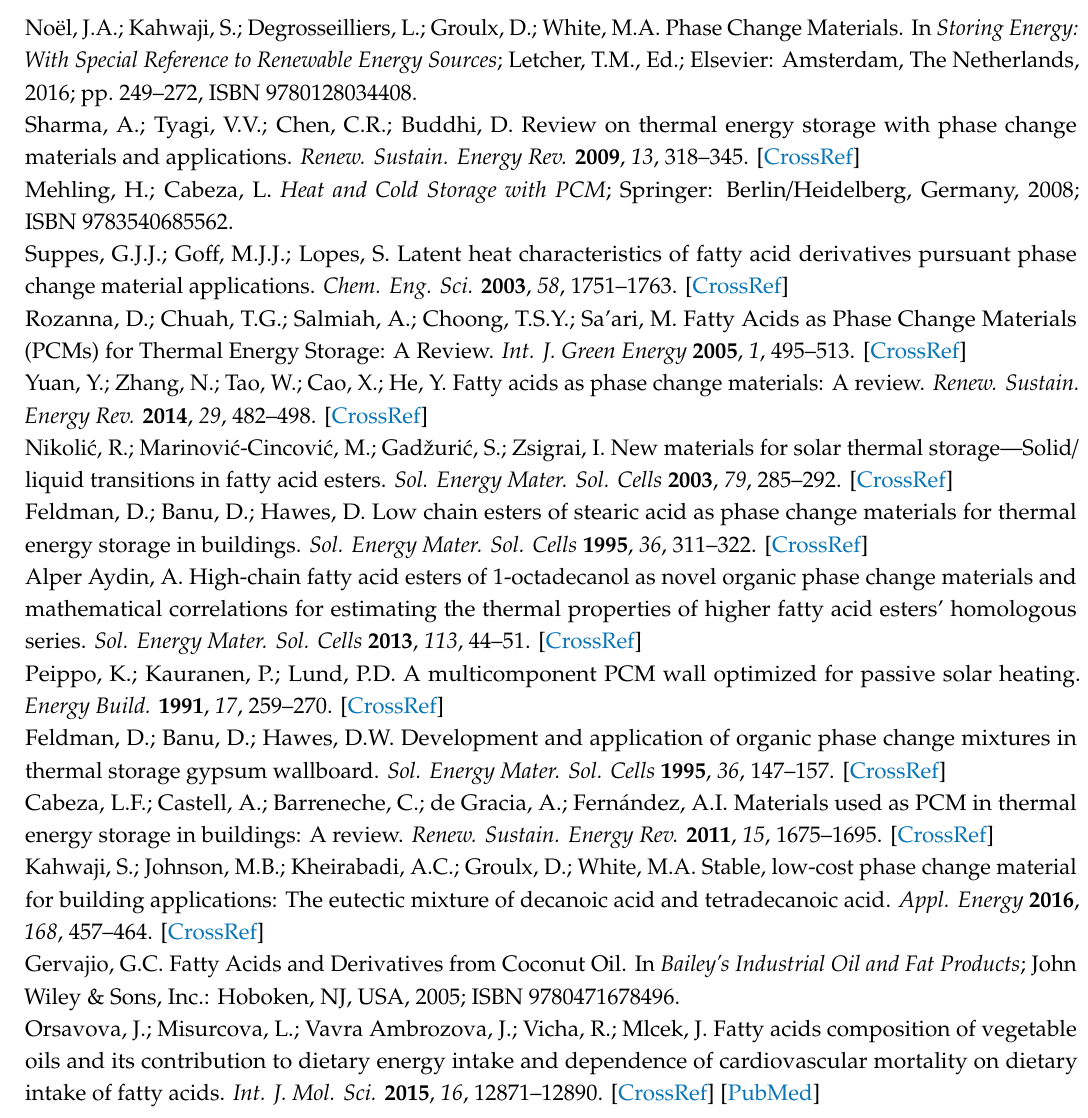
Figure S1: Edible oils studied; Figure S2: Bench-top setup for bulk heating / cooling curves; Figure S3: DSC curve for margarine M2 at 2 K / min; Figure S4: DSC curves for vegetable shortening at 2 K / min; Figure S5: DSC curves for coconut oil (refined and virgin) at 0.5 and 2 K / min; Figure S6: Heating curve for melting of refined coconut oil; Figure S7: Photos of refined coconut oil during melting; and Figure S8: Schematic diagram of domestic greenhouse used for